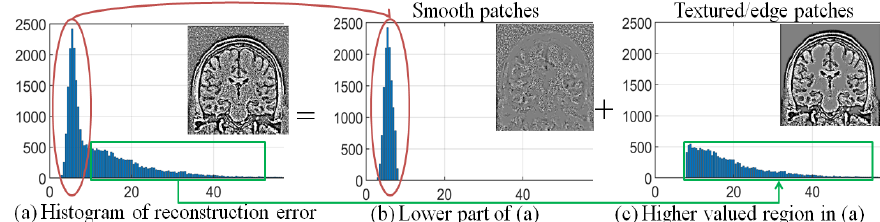
Figure 4. Demonstration of the relation between reconstruction error vector e and patch structure, i.e., smooth and textured/edge, using the noise adaptive threshold τ 1 , for (mean subtracted patches of) a randomly selected image corrupted with 2% Rician distributed noise: ( a ) Histogram of reconstruction error values e and the corresponding image, ( b ) histogram of reconstruction error values less than τ 1 and the corresponding patches in the image, and ( c ) histogram of reconstruction error values greater or equal to τ 1 and the corresponding patches in the image.